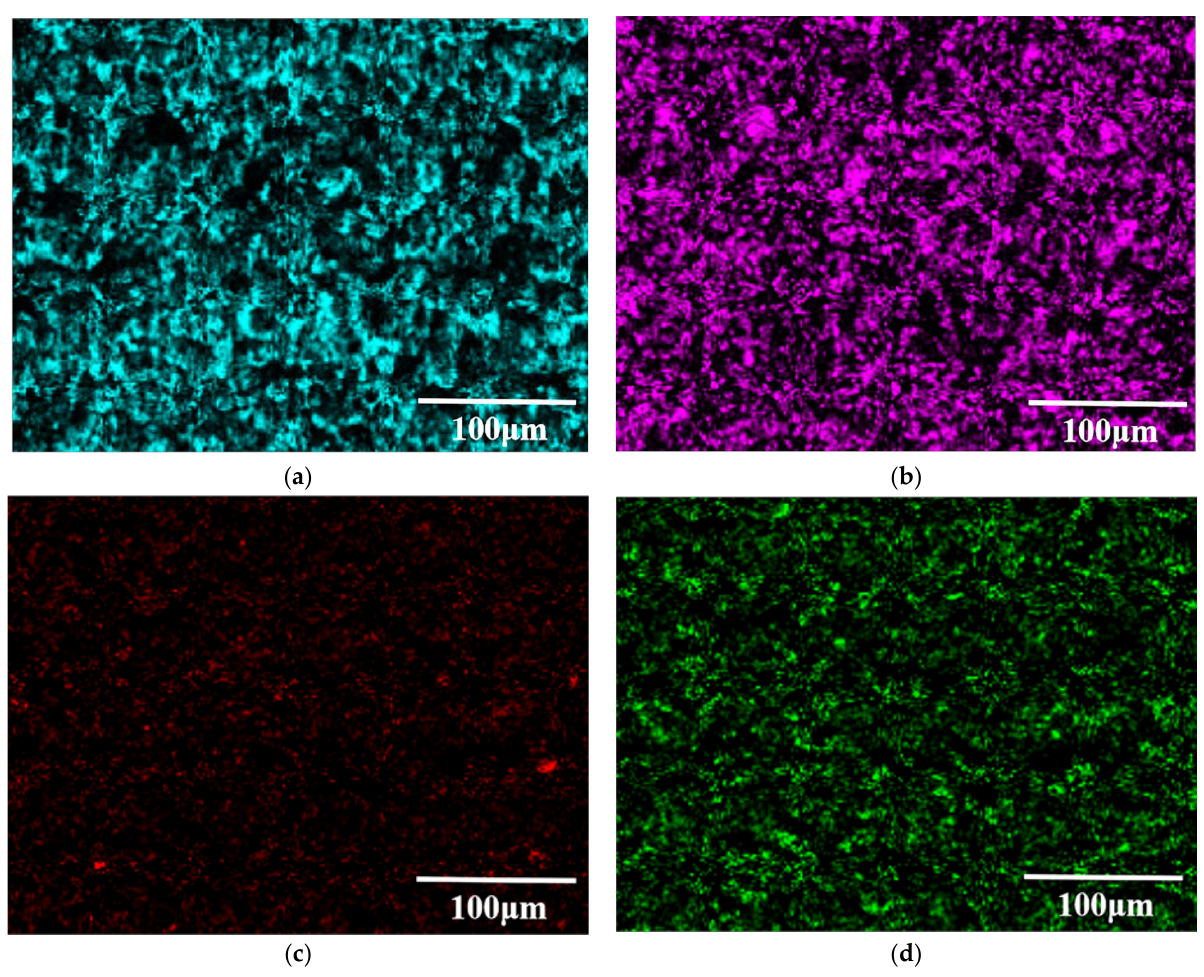
Figure 7. Surface element distribution of Al-20TiC-0.3G with 15-pulse-treated sample: ( a ) element distribution of Al; ( b ) element distribution of Ti; ( c ) element distribution of C; ( d ) element distribu- tion of O.